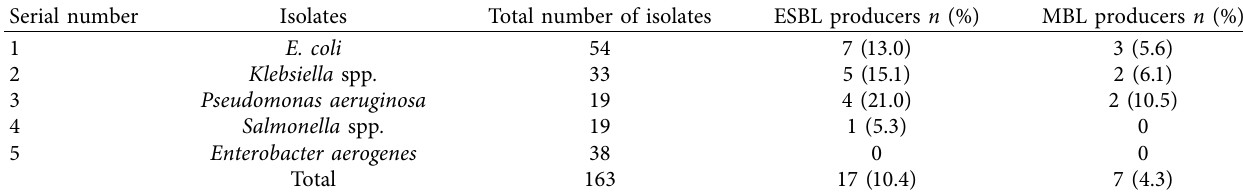
Table 6: Frequency of ESBL and MBL producing Gram negative